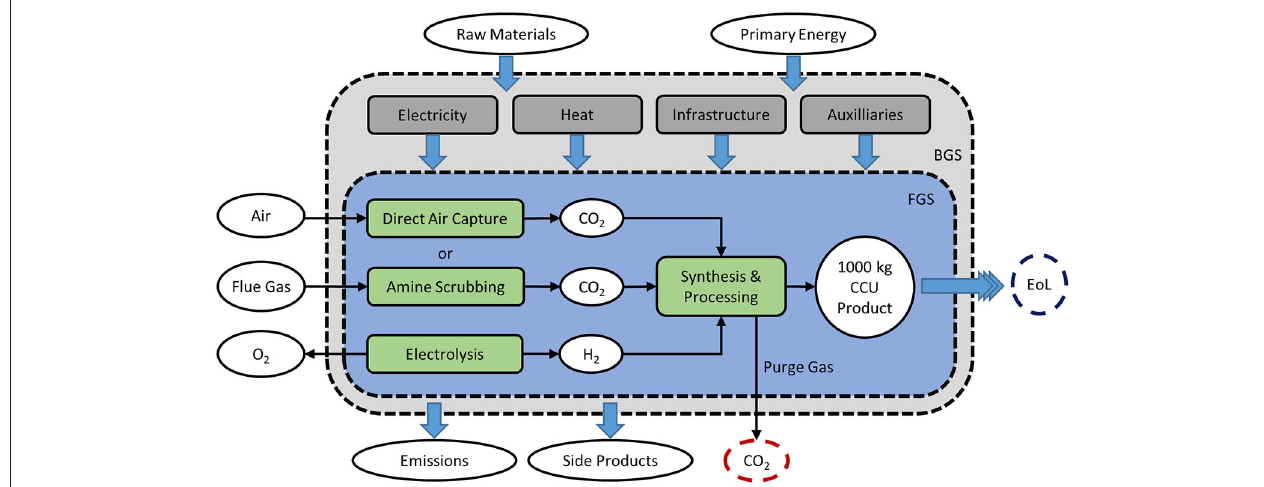
FIGURE 1 | Product system containing fore- and background systems (FGS = blue, BGS = gray). CO 2 can be extracted from air by DAC, or from a point-source using amine scrubbing. Hydrogen is provided by alkaline electrolysis. CCU products are synthesized and processed for purification. The functional unit (FU) is defined as 1,000kg of a CCU product. EoL = end-of-life, side products = butene, alkylated aromatics, etc. (compare Table 2